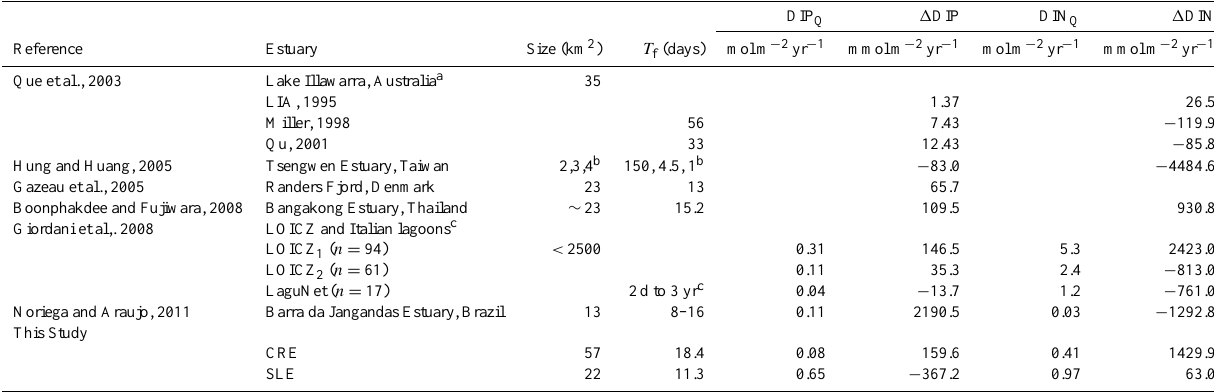
Table 6. Summary of average DIP and DIN loadings (DIP Q and DIN Q ) and system DIP ( 1 DIP) and DIN ( 1 DIN) production ( + ) or consumption ( − ) from several studies using the LOICZ methods. Similar units were derived among the studies for loadings (molesm − 2 yr − 1 ) and production/consumption (mmolm − 2 yr − 1 ). Studies with daily rates were multiplied by 182.5 days to calculate seasonal values that were summed to derive annual estimates. Studies reporting a single daily rate were multiplied by 365 days to derive annual estimates. DIP Q 1 DIP DIN